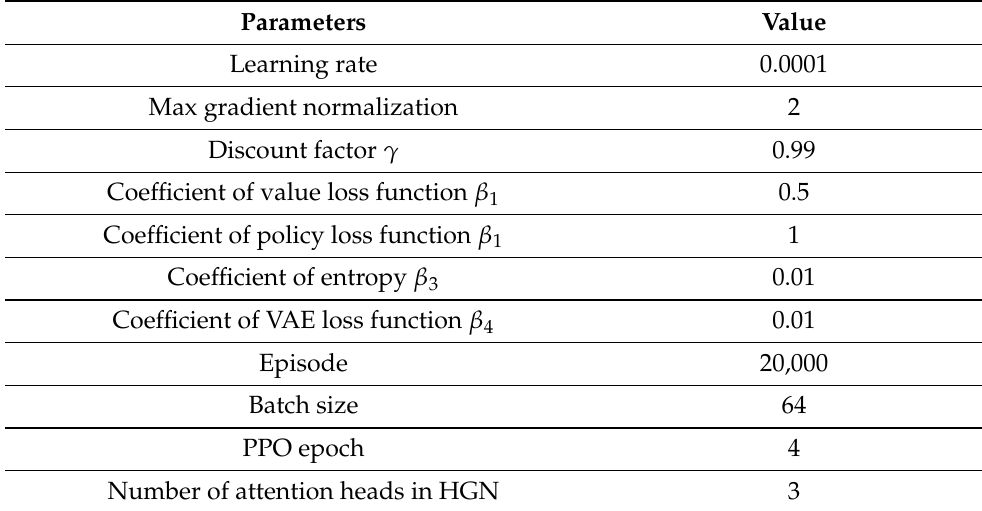
Table 1. Parameters of